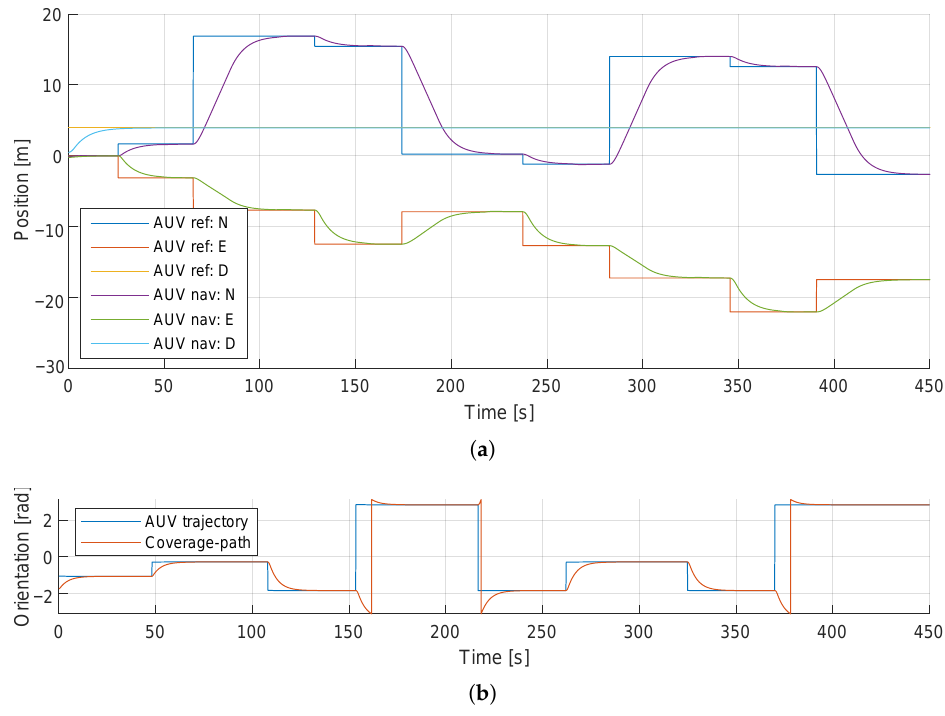
Figure 11. AUV tracking trajectory for the simulation model in NED coordinate system: ( a ) North, East, and Down, ( b ) Yaw.